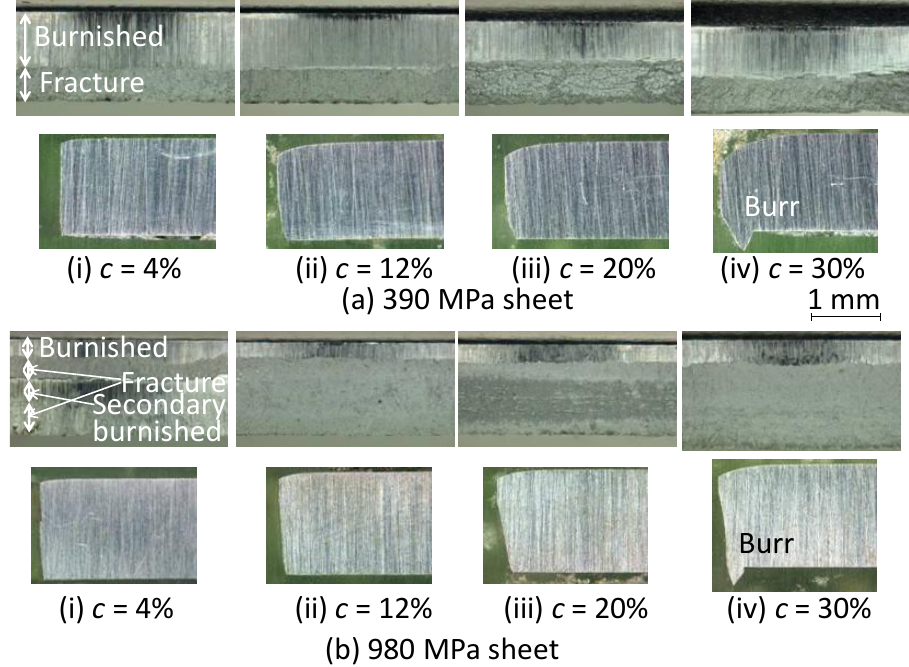
Figure 2. Surfaces and cross-sections of punched edges for ( a ) 390 MPa ( b ) 980 MPa high strength steel sheets.